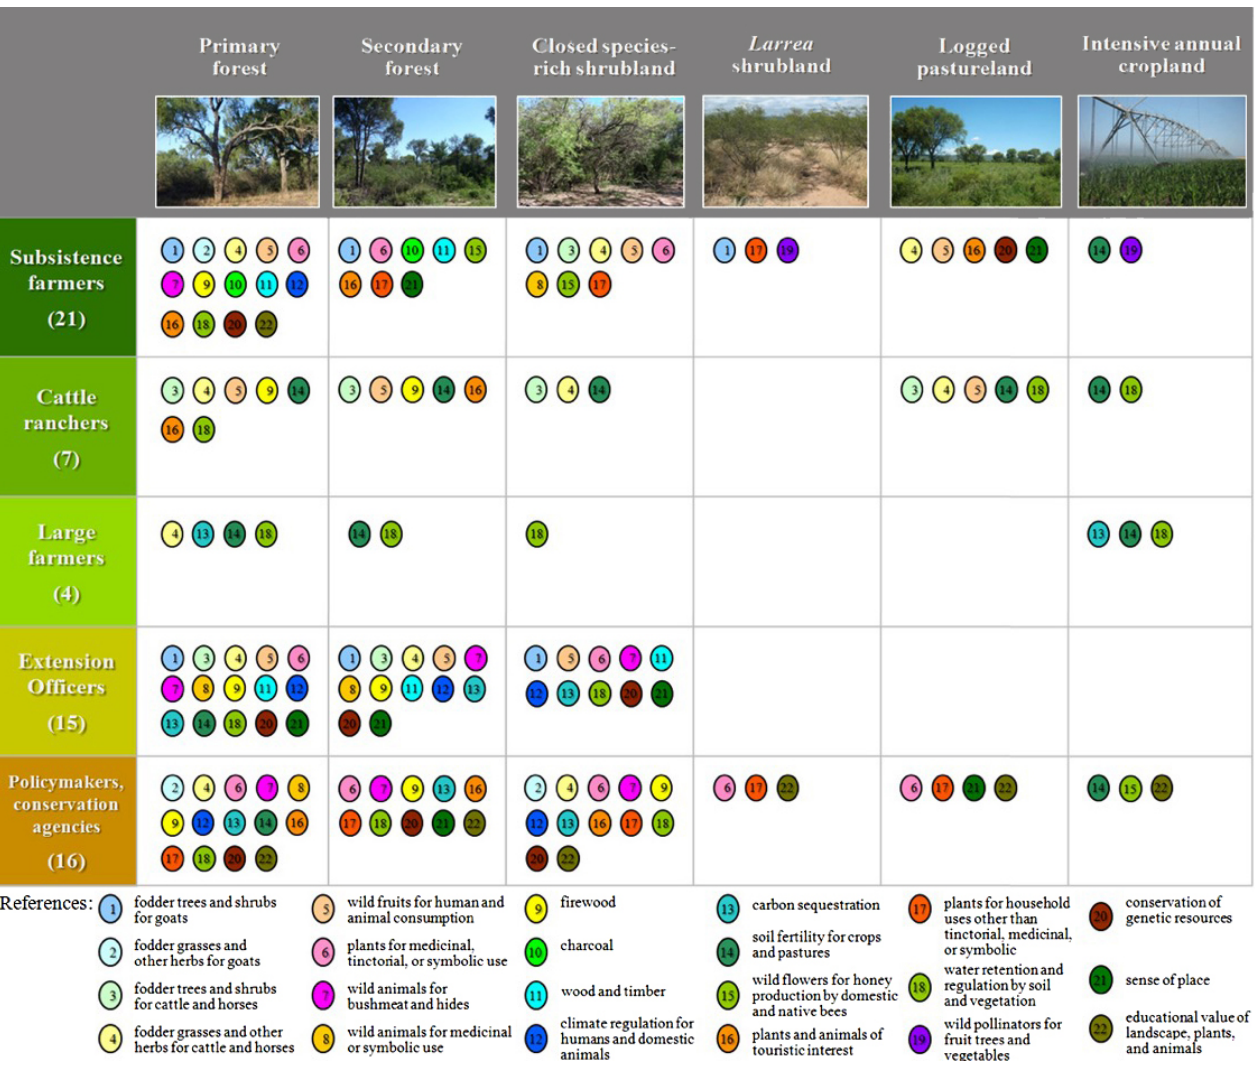
Fig. 3 . Ecosystem services (ES) perceived as important by social actors (SA) and their link with the ecosystem types that are able to supply them, based on the results of the focus groups (see Selection of ES). The number between brackets in the first column represents the total number of ES perceived by each SA. For a detailed ranking of each ecosystem service by each social actor